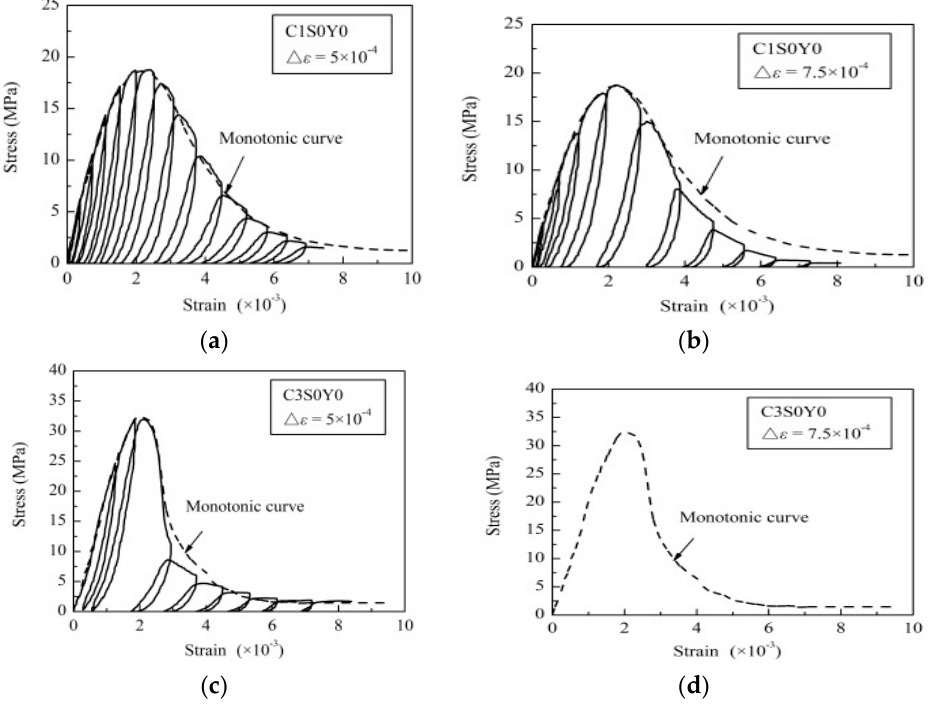
Figure A1. Cyclic stress–strain curves of unconfined concrete specimen: ( a ) C1S0Y0, Δε = 5.0 × 10 − 4 ; ( b ) C1S0Y0, Δε = 7.5 × 10 − 4 ; ( c ) C3S0Y0, Δε = 5.0 × 10 − 4 ; and ( d ) C3S0Y0, Δε =7.5 × 10 − 4 .